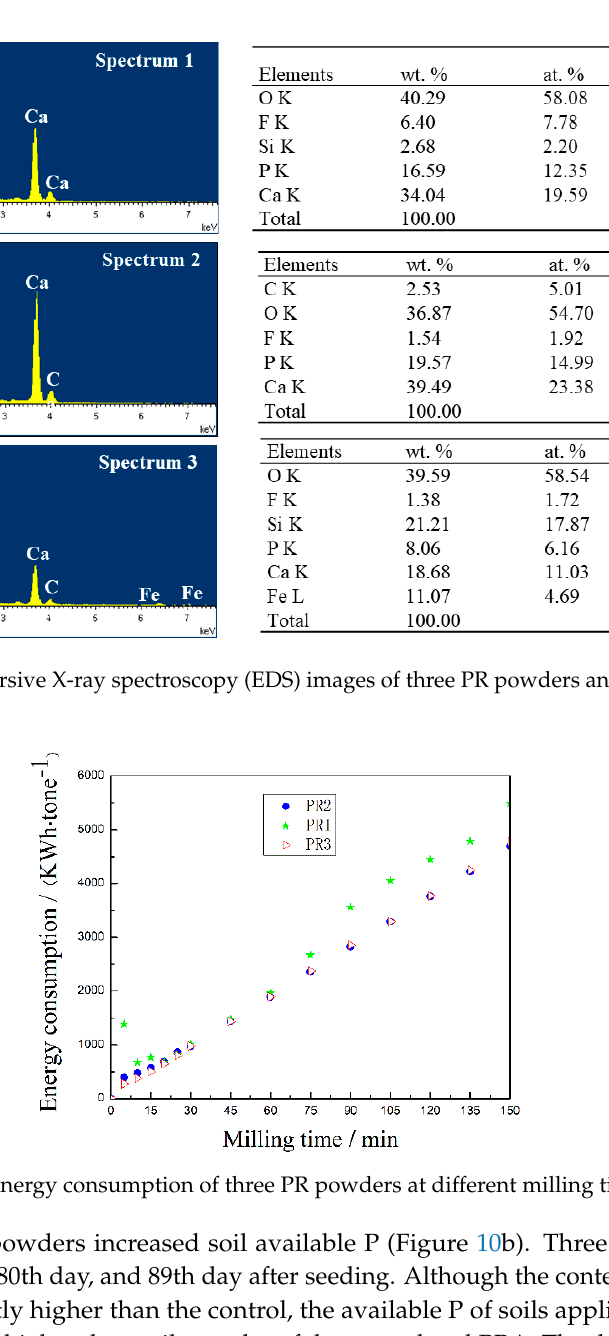
Figure 8. Energy consumption of three PR powders at different milling times.